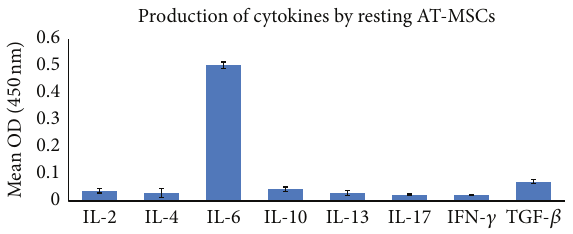
Figure 3: Cytokine profile secreted by AT-MSC in resting state. AT-MSC showed higher IL-6 and TGF- 𝛽 production compared to other cytokines. Data presented the mean ± SD of five independent experiments. Resting AT-MSCs cytokine profile was used as blank to subtract background absorbance in coculture experiments for cytokine